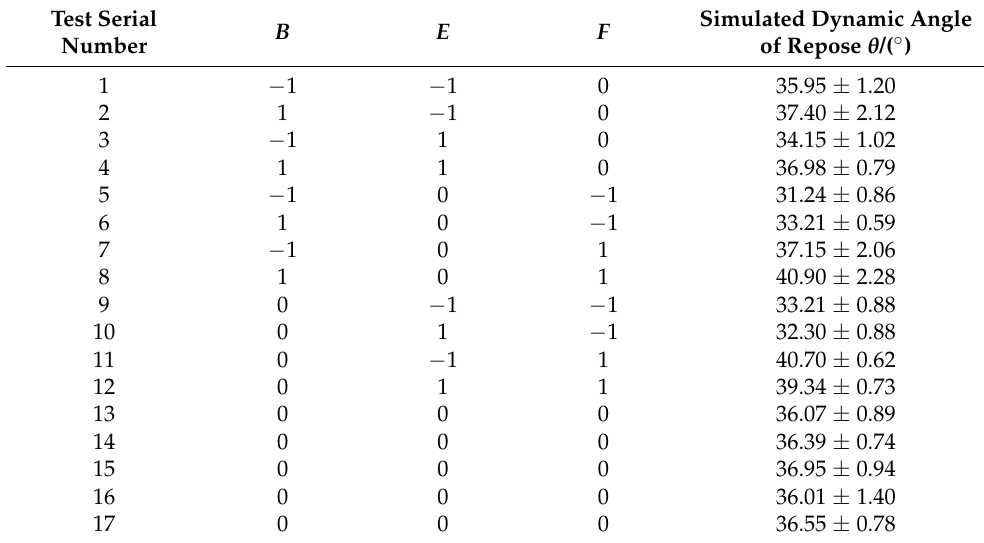
Table 5. Box–Behnken test protocol and results.